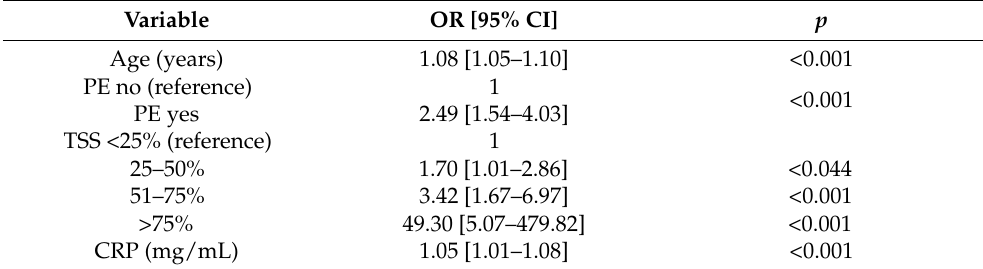
Table 3. Multivariate logistic analysis for in hospital